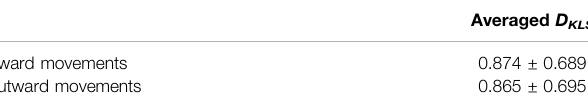
TABLE 2 | A comparison of the averaged symmetric KL-divergence on both inward and outward movements over all experiments and participants, the mean and standard deviation are computed by averaging each D KLS values in Supplementary Figure S1